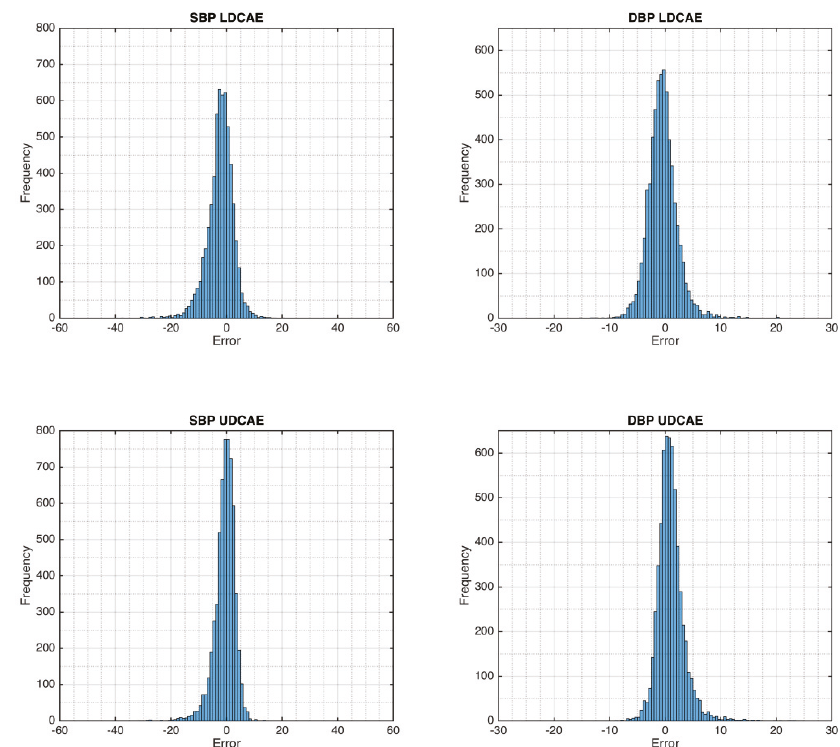
Figure 3. The error comparison between DCAE-based models and MP60 IntelliVue Patient Monitor.